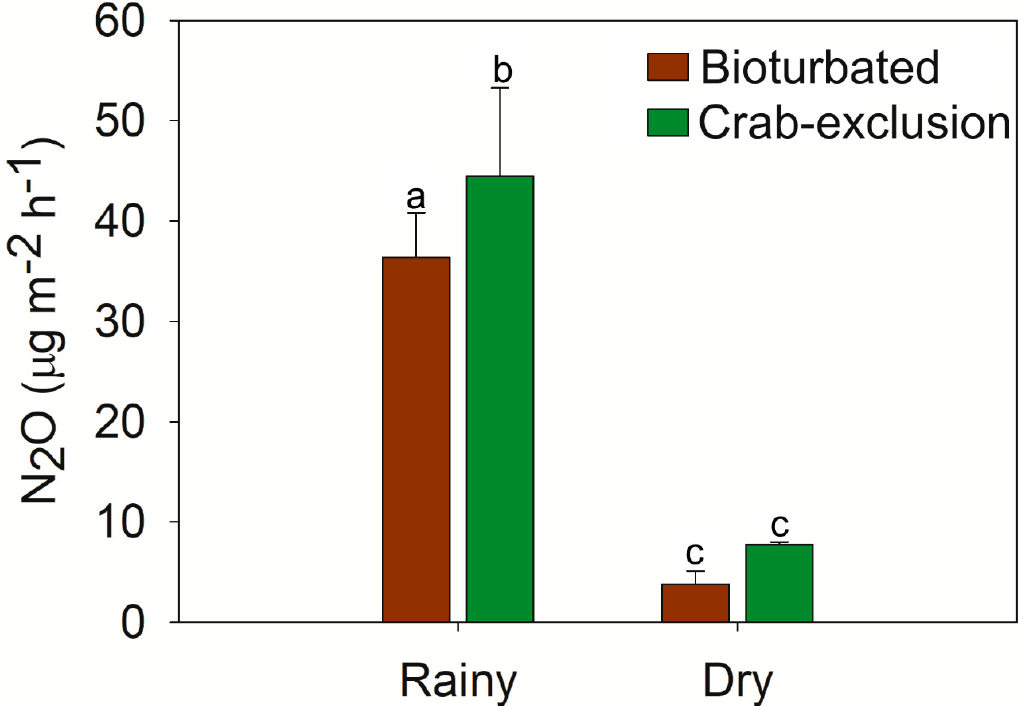
Figure 4. N 2 O emissions for bioturbated and crab-exclusion mangrove soils for both seasons. Labelled bars (standard error bars) with di ff erent lowercase letters (a, b, and c) on the bars indicate statistical di ff erences among Seasons / Sites (Rainy / Bioturbated, Rainy / Crab-exclusion, Dry / Bioturbated, Dry / Crab-exclusion), at the 5% probability level (non-parametric Friedman test). p -values are provided in Table S7.